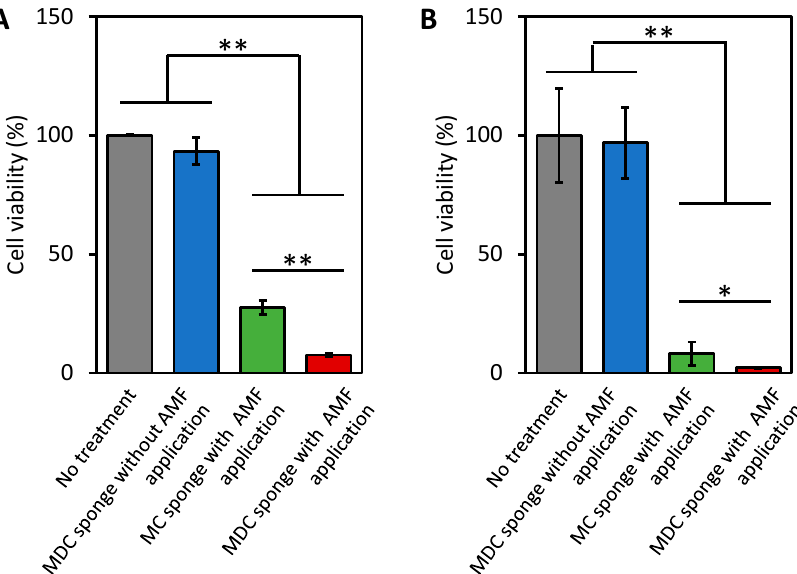
Figure 7. Viability of untreated HeLa cells incubated without sponges and AMF application, with the MDC sponge and no AMF application, with MC sponge (without DOX) and 15-min AMF application, and with MDC sponge and 15-min AMF application at 3 ( A ) and 5 ( B ) days, respectively (* p < 0.05 and ** p < 0.01).